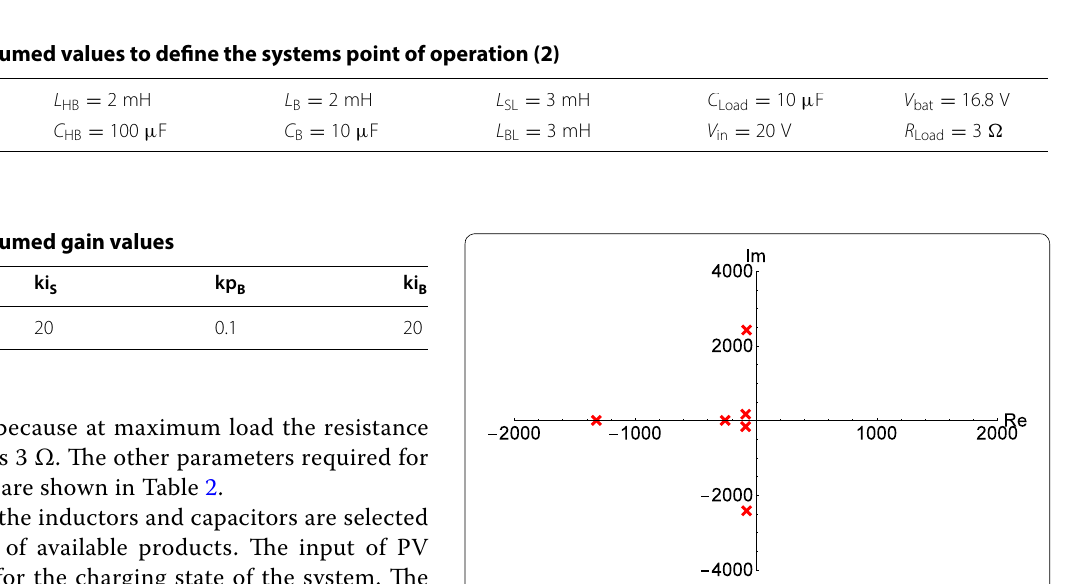
Fig. 3 The pole–zero plot for the charging